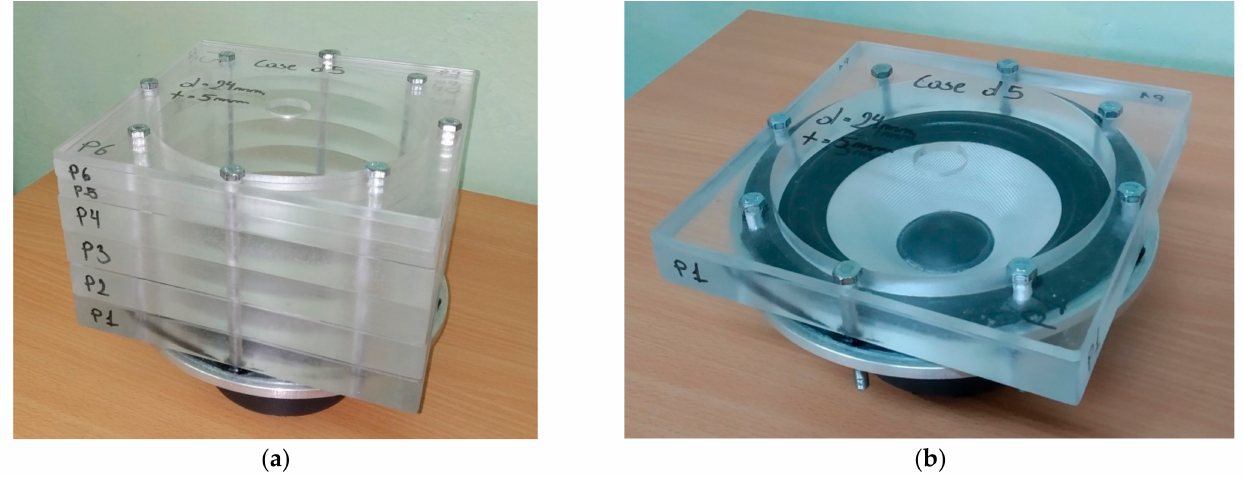
Figure 2. Modular SJ actuator: ( a ) maximum volume of the cavity; ( b ) minimum volume of the